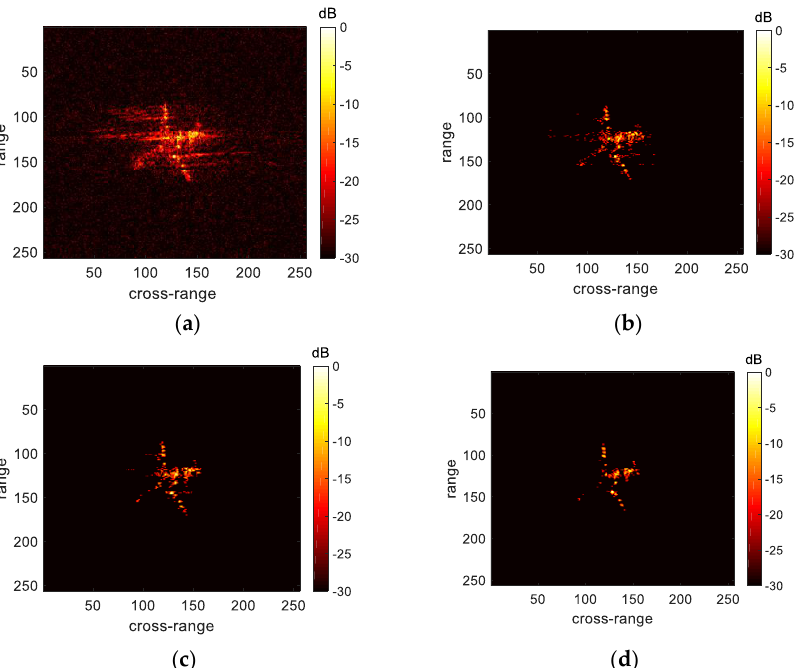
Figure 7. ISAR imaging results for Yak-42 by different methods under SNR = 5 dB: ( a ) the result of RD method; ( b ) the result of HAF–ICPF method; ( c ) the result of IPCPF–RWVD method; ( d ) the result of the proposed method.